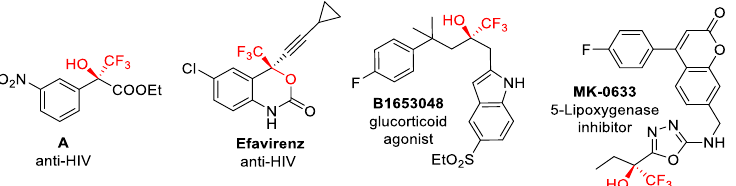
Figure 1. Examples of pharmaceuticals containing α -trifluoromethylated tertiary alcohol